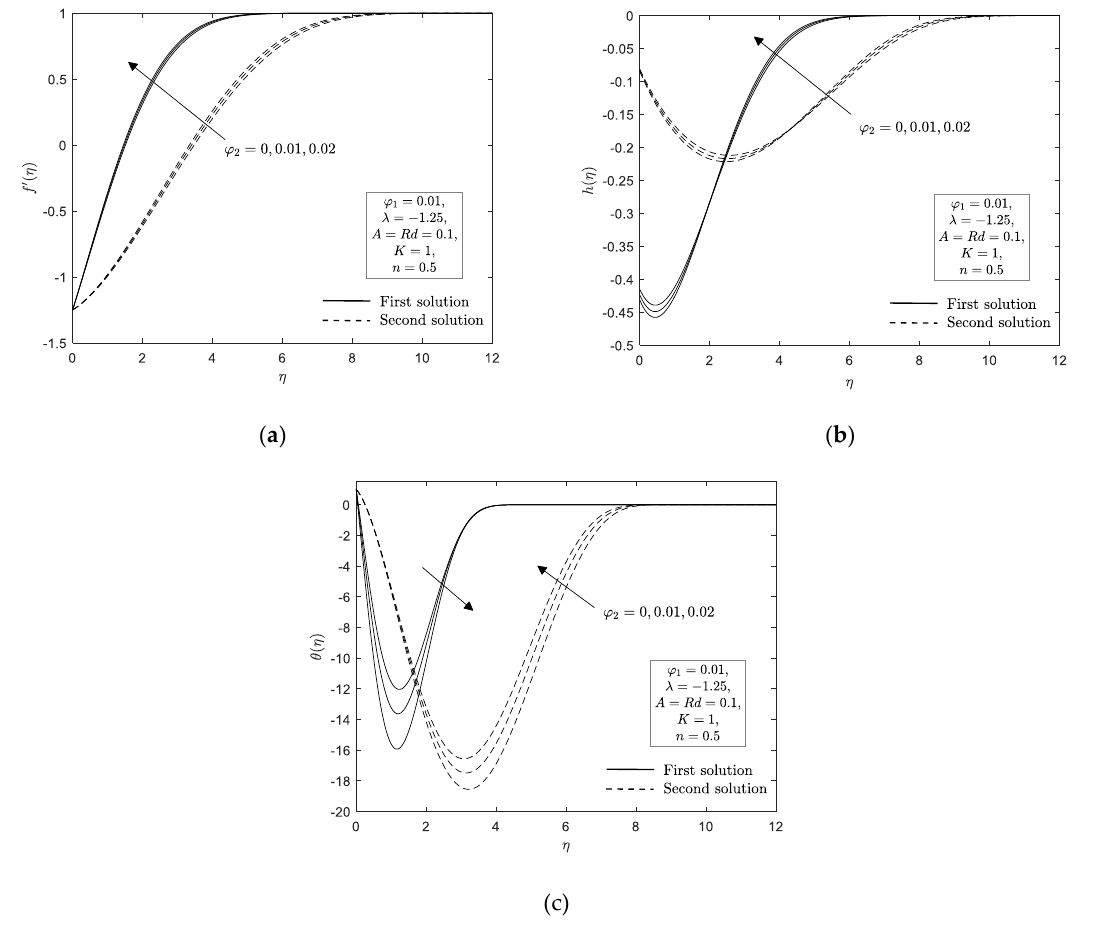
(cid:48) ( η ) ; ( b ) h ( η ) ; ( c ) θ ( η ) for various ϕ Figure 3. ( a )   f  ; ( b )   h  ; ( c )    for various 2  Figure 3. ( a ) f 2 . Figure 4a,b show the impact of unsteady parameter A = 0, 0.1, 0.2 on the local